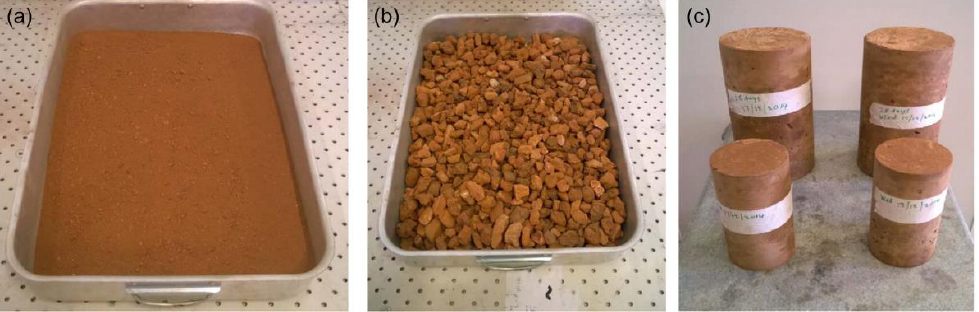
Figure 2. ( a ) Fine and ( b ) coarse iron ore tailings, and ( c ) tailings aggregate concrete. Source: [87].